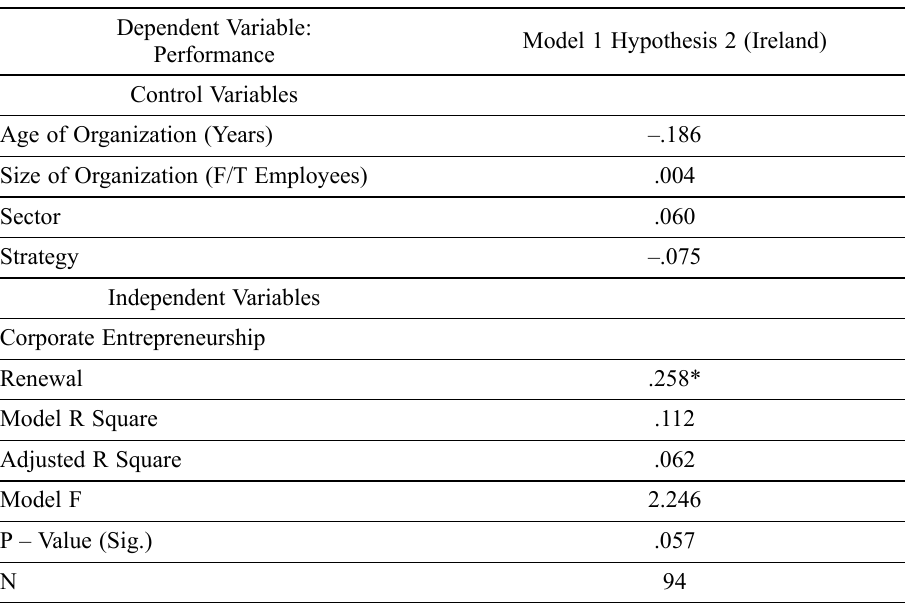
Table 6. Regression analysis results (public